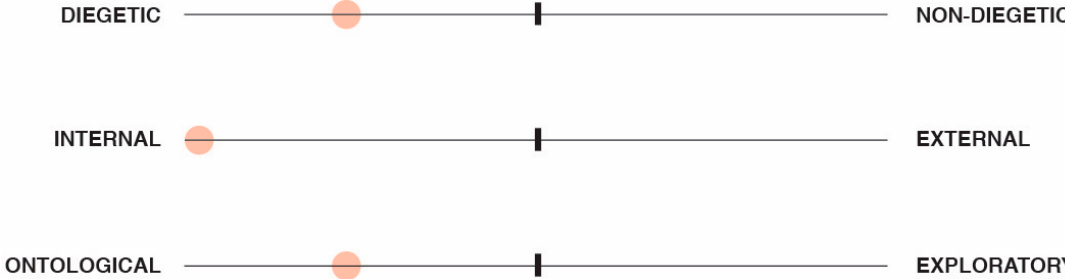
Figure 3. Mapping the Nintendo Wiimote game console device onto the TENF.